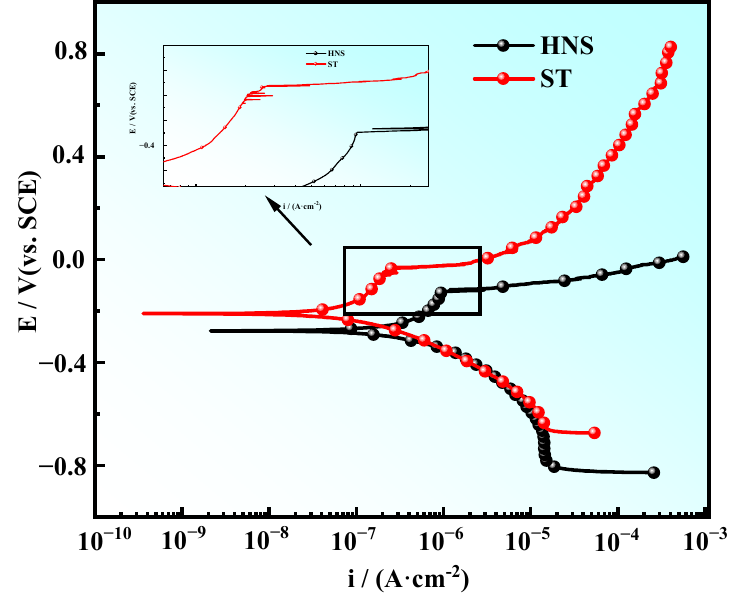
Table 1. Fitting results of the polarization curves for HNS and ST.